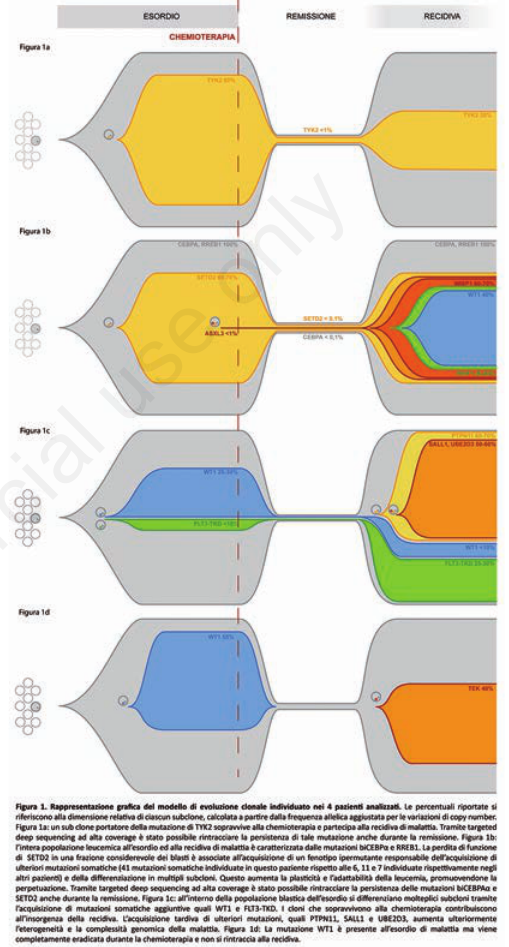
Figura 1. Rappresentazione grafica del modello di evoluzione clonale individuato nei 4 pazienti analizzati.